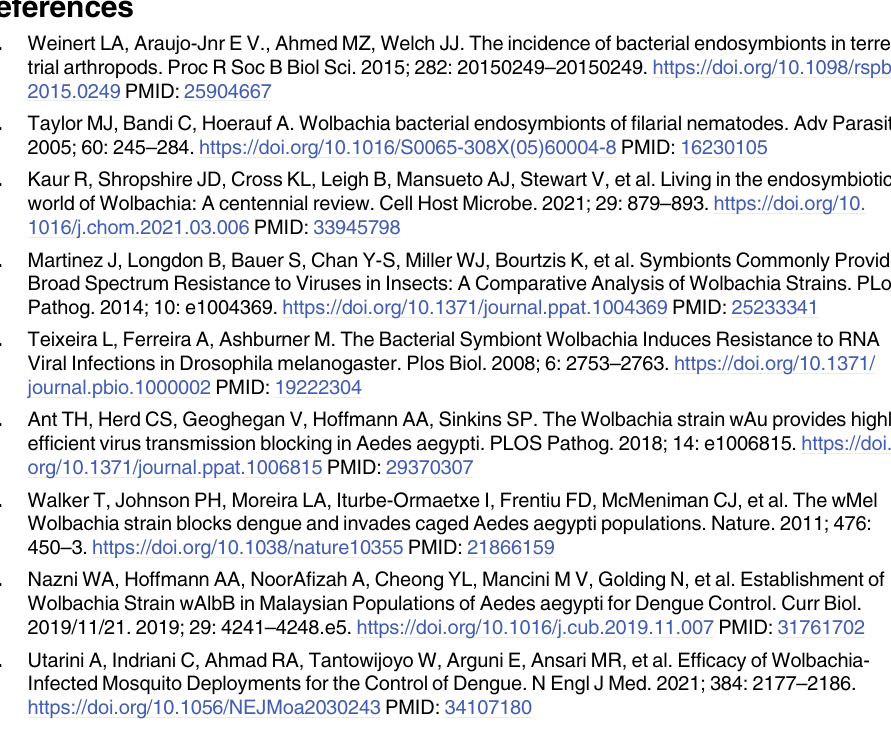
S2 Table. w AlbA prophage regions. S3 Table. Plasmid gene BLASTP hits and HHpred predicted domains. S4 Table. List of Wolbachia genome assemblies and detected plasmid-like regions. S5 Table. List of PCR and qPCR